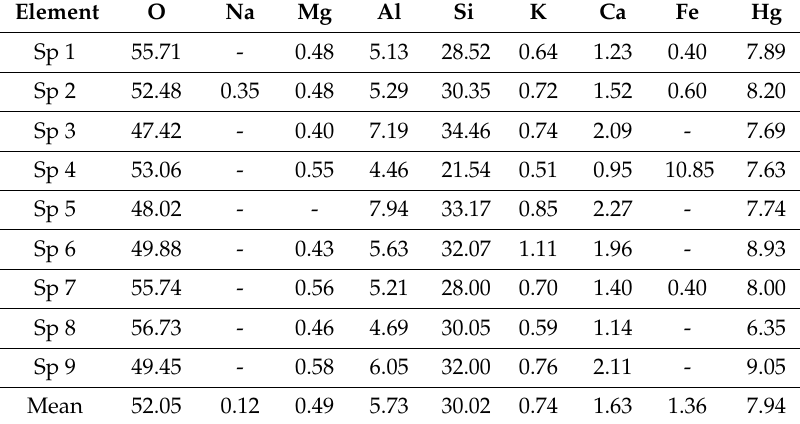
Table 2. Mass percentage values of the detected elements on the nine marked surfaces (Spectra, Sp) for NZHg.